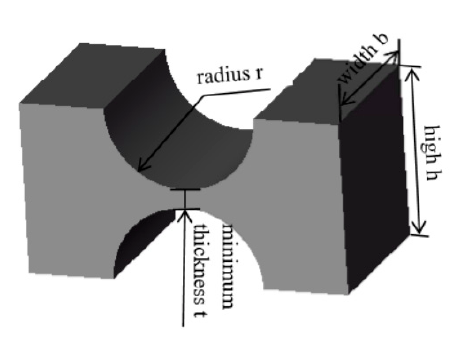
Figure 4. Straight round flexure hinge. Table 1. Design parameters of straight round flexure hinge.